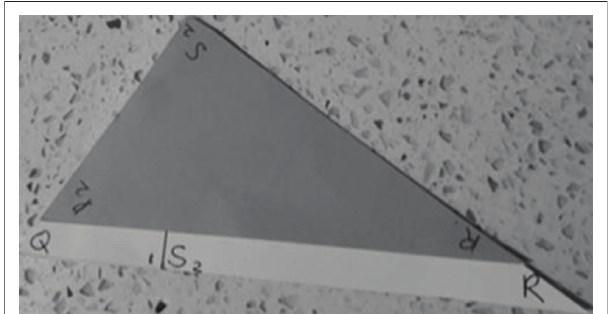
FIGURE 6: Reorientation of the light grey and white